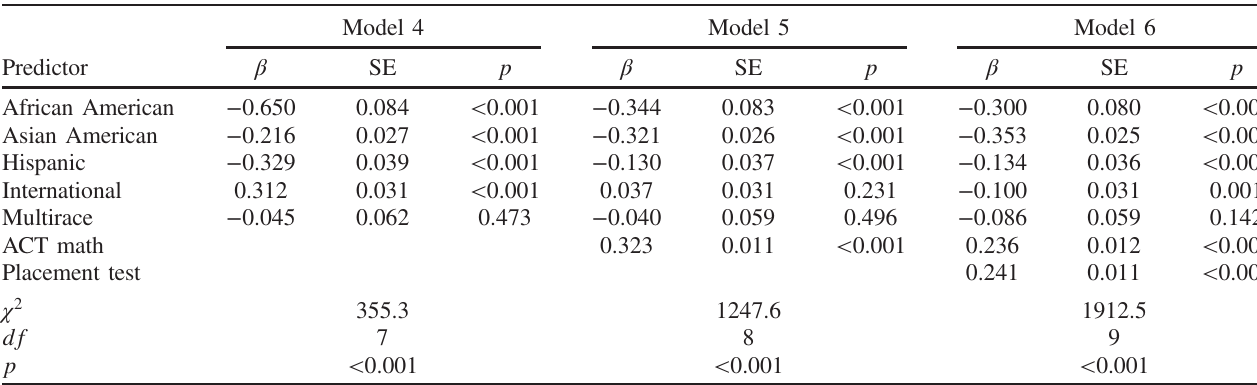
TABLE V. Differentiated models predicting physics 1 final exam scores a